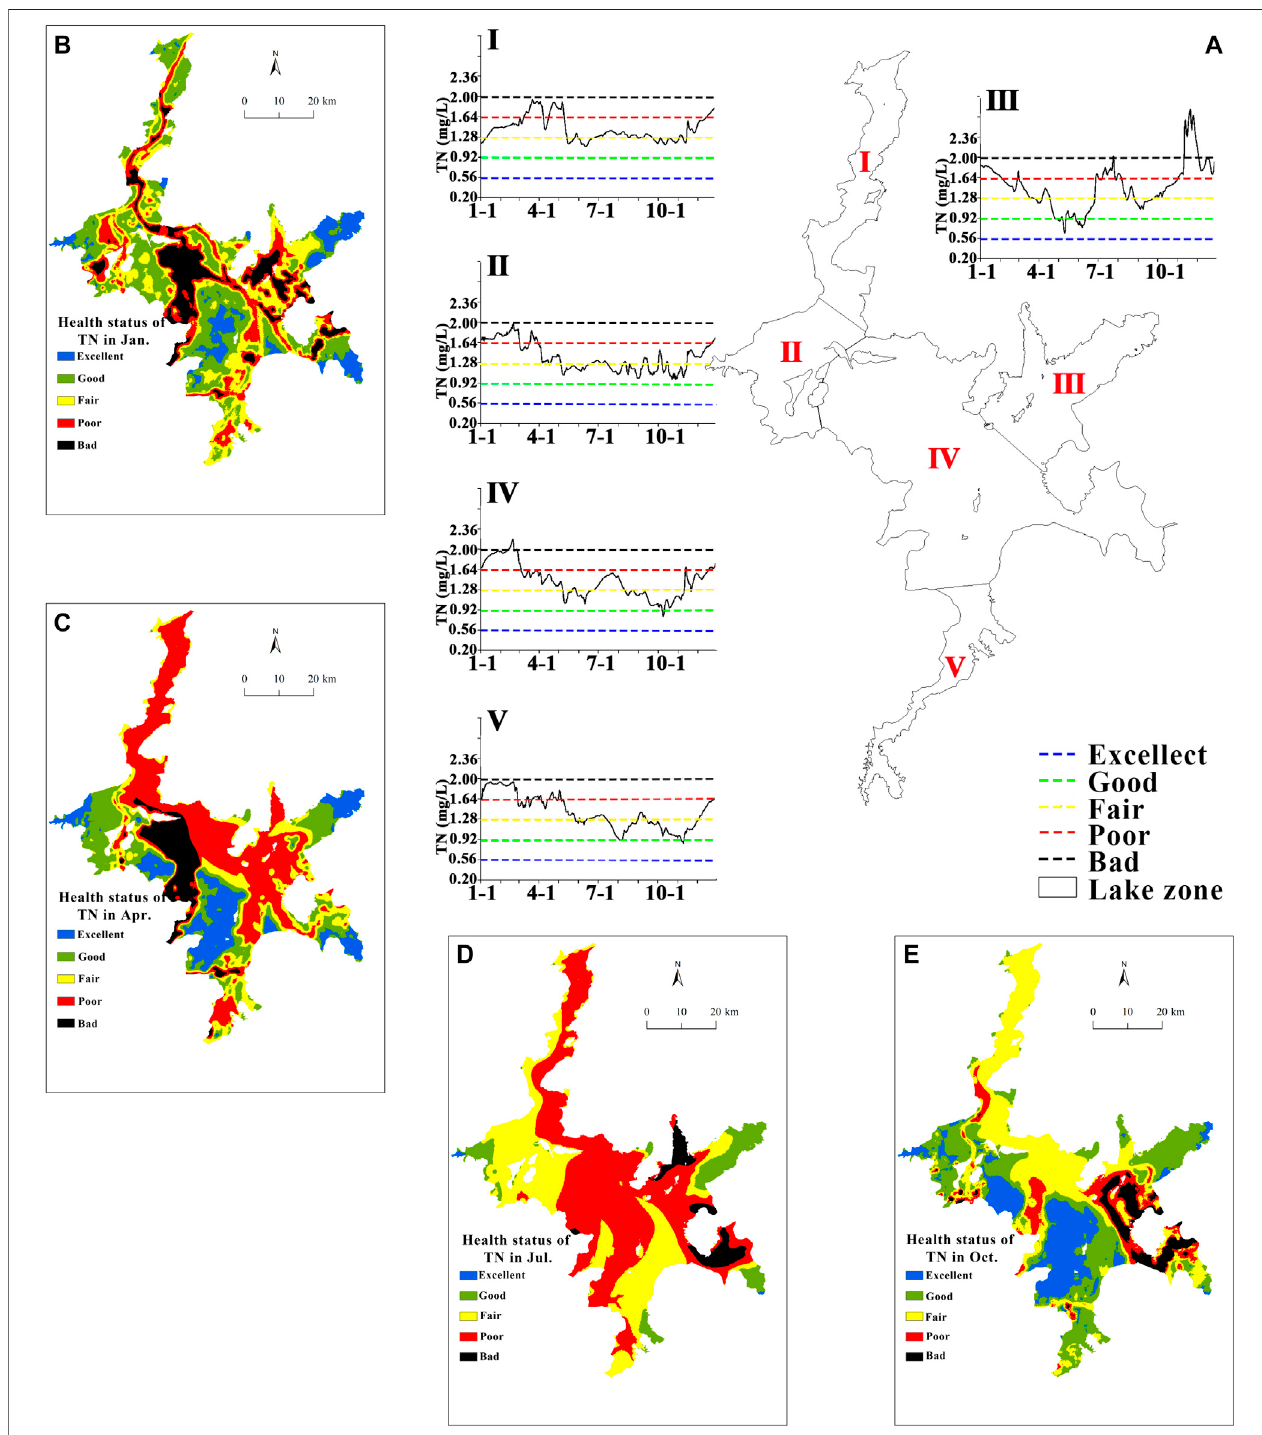
FIGURE7| Real-timehealthassessmentcurvesandspatiotemporaldistributionsofTNinthelakezonesofLakePoyangin2015. (A) Real-timehealthassessment curves of TN, (B – E) Spatiotemporal distributions of TN in Jan.,Apr.,Jul.,Oct.